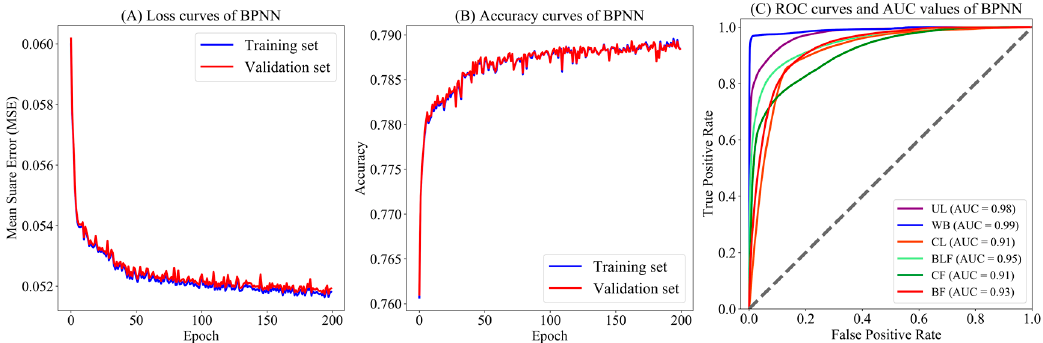
Figure 7. ( A ) The mean square error (MSE) of BPNN, ( B ) the accuracy of BPNN, and ( C ) the receiver operating characteristic (ROC) curves and area under ROC curve (AUC) values of